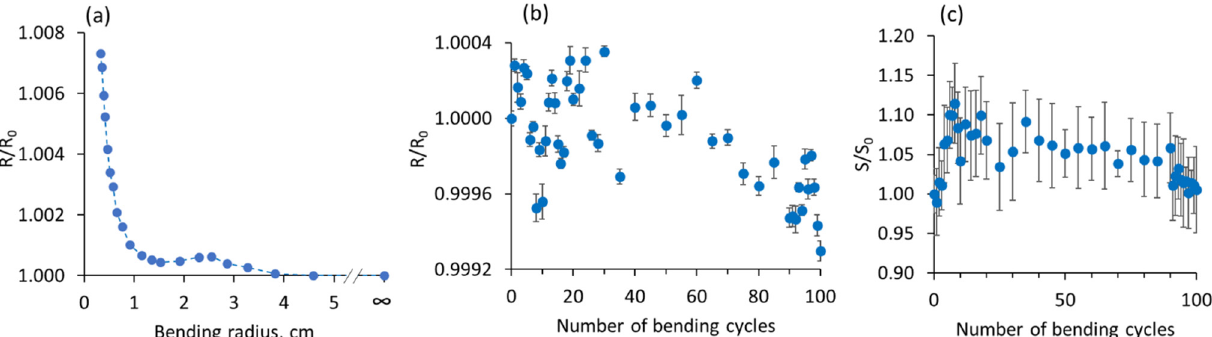
Figure 4. Bending tests of PVA/MWCNT-Sb 2 Te 3 composite with 25 wt.% filler: ( a ) relative changes in the resistance vs. its bending radius, and ( b ) relative changes in the resistance during 100 consequent bending cycles down to 0.3 cm (R is the resistance of bent composite, R 0 is the resistance of the composite before the first bending cycle); ( c ) relative changes of the Seebeck coefficient of the composite during 100 consequent bending cycles down to 0.3 cm (S is the Seebeck coefficient of bent composite, S 0 is the Seebeck coefficient of the composite before the first bending cycle). The error bars represent the standard deviation (SD) for average resistance ( b ) and average Seebeck coefficient ( c